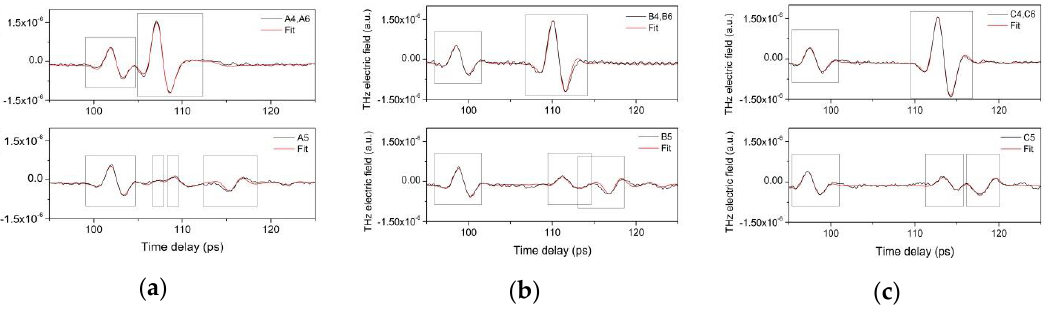
Figure 8. THz pulses reflected from different areas not covered by varnishes: ( a ) thin Gy1 on metal tape (upper image), thin Gy1 layer on red bole (lower image); ( b ) intermediate Gy1 on metal tape (upper image), intermediate Gy1 on red bole (lower image); ( c ) thick Gy1 on metal tape (upper image), thick Gy1 on red bole (lower image).